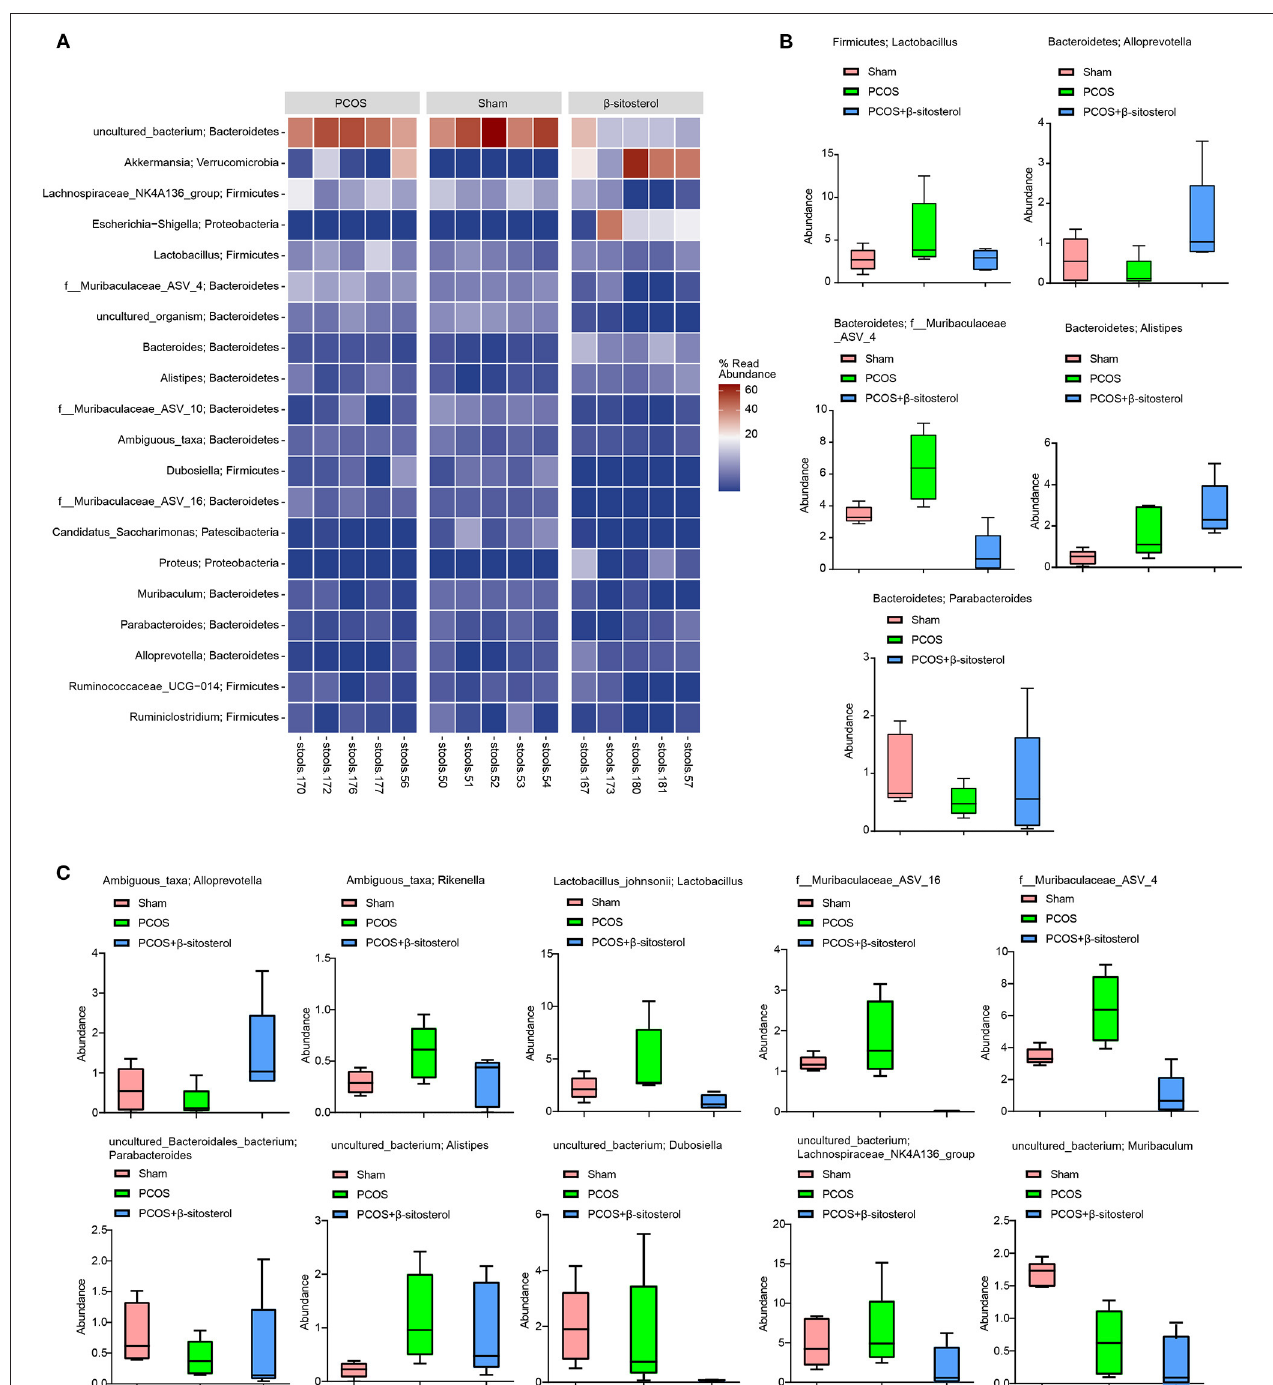
FIGURE 5 | Effects of β -sitosterol on the abundance of specific microbiota in PCOS-like mice. (A) Heat map showed that the abundances of the first 20 species were differentially expressed in groups. (B) Relative abundance of the five bacterial categories at the phylum level. Top five bacteria: Firmicutes-Lactobacillus , Bacteroidetes-Alloprevotella , Bacteroidetes-Parabacteroides , Bacteroidetes-f_Muribaculaceae_ASV_4 , and Bacteroidetes-Alistipes. (C) Relative abundance of the top 10 bacterial categories at the species level. Top 10 bacteria: Ambiguous_taxa-Alloprevotella , Ambiguous_taxa-Rikenella , Lactobacillus_johnsonii-Lactobacillus , f_Muribaculaceae_ASV_16 , f_Muribaculaceae_ASV_4 , uncultured_Bacteroidales_bacterium-Parabacteroides , uncultured_bacterium-Alistipes , uncultured_bacterium-Dubosiella , uncultured_bacterium-Lachnospiraceae_NK4A-136_group , and uncultured_bacterium-Muribaculum . PCOS, polycystic ovary